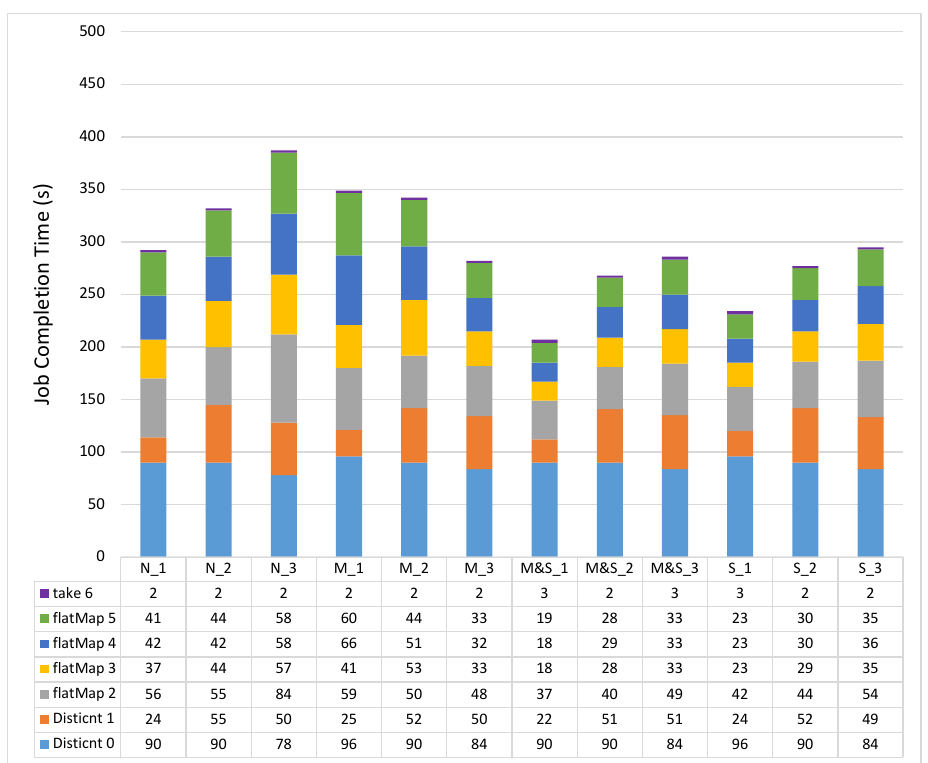
Figure 3. The PageRank job execution time for 500 MB dataset per stage (s). Each shade represents each stage in a Spark job. Overall, M&S_1 case shows the best